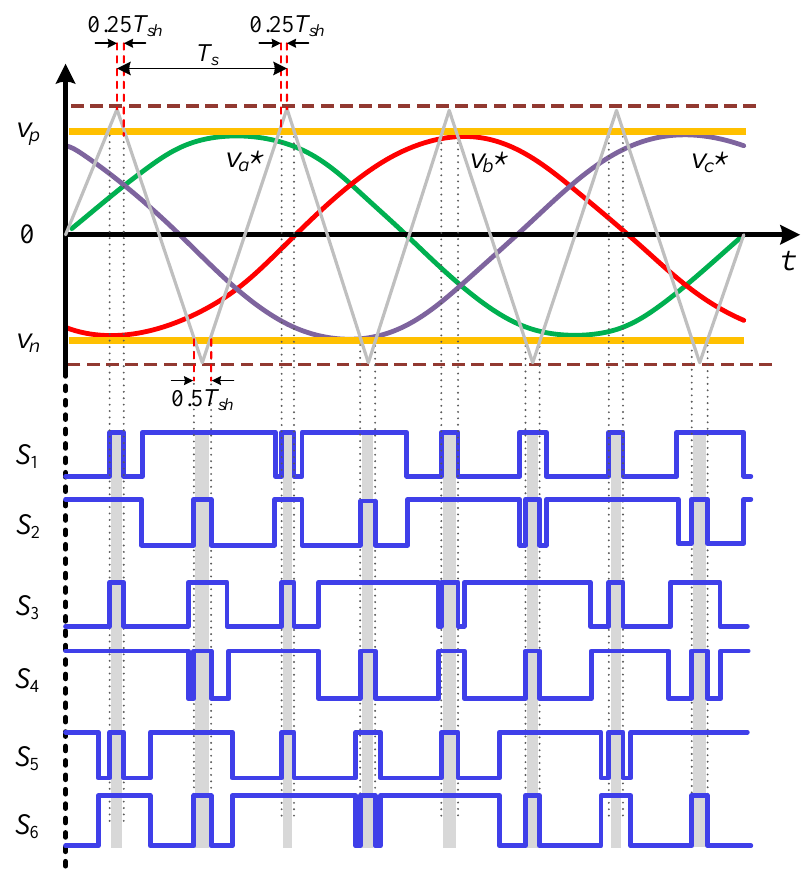
Figure 2. Three-phase simple boost PWM